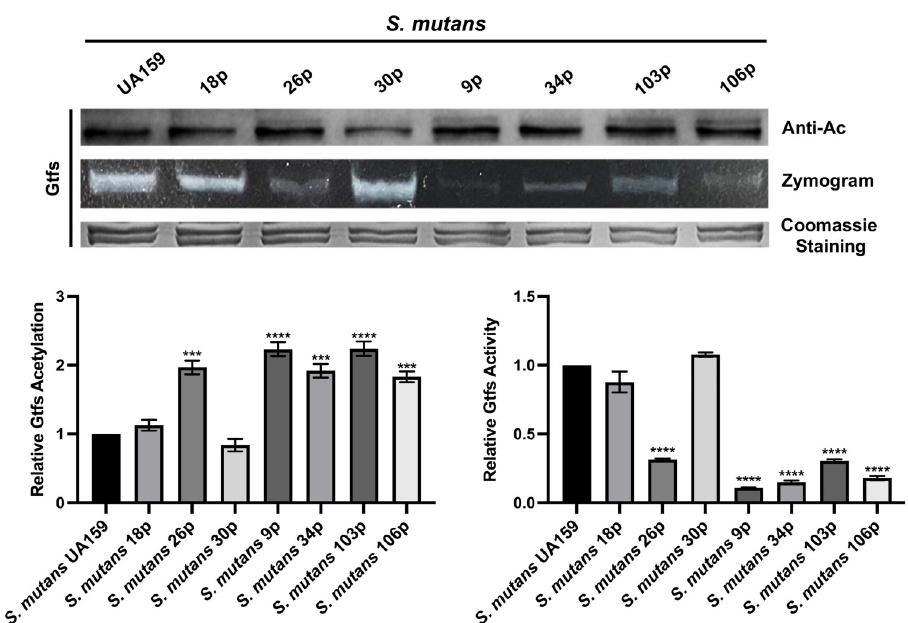
Fig 7. Effect of actG on the acetylation level and enzyme activity of Gtfs in clinically isolated strains. The extracted proteins were analyzed by Coomassie staining, anti-acetyl lysine Western blotting, and zymogram analysis. The band signals were quantified with Image J software and normalized to the control. Results are presented as mean ± SD ( ��� P < 0.001 or ���� P <